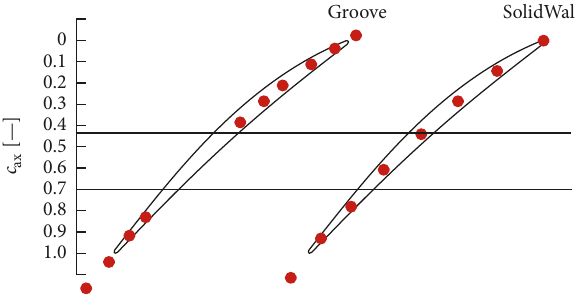
Figure 3: Arrangement of pressure transducers over rotor, left: Groove, right: